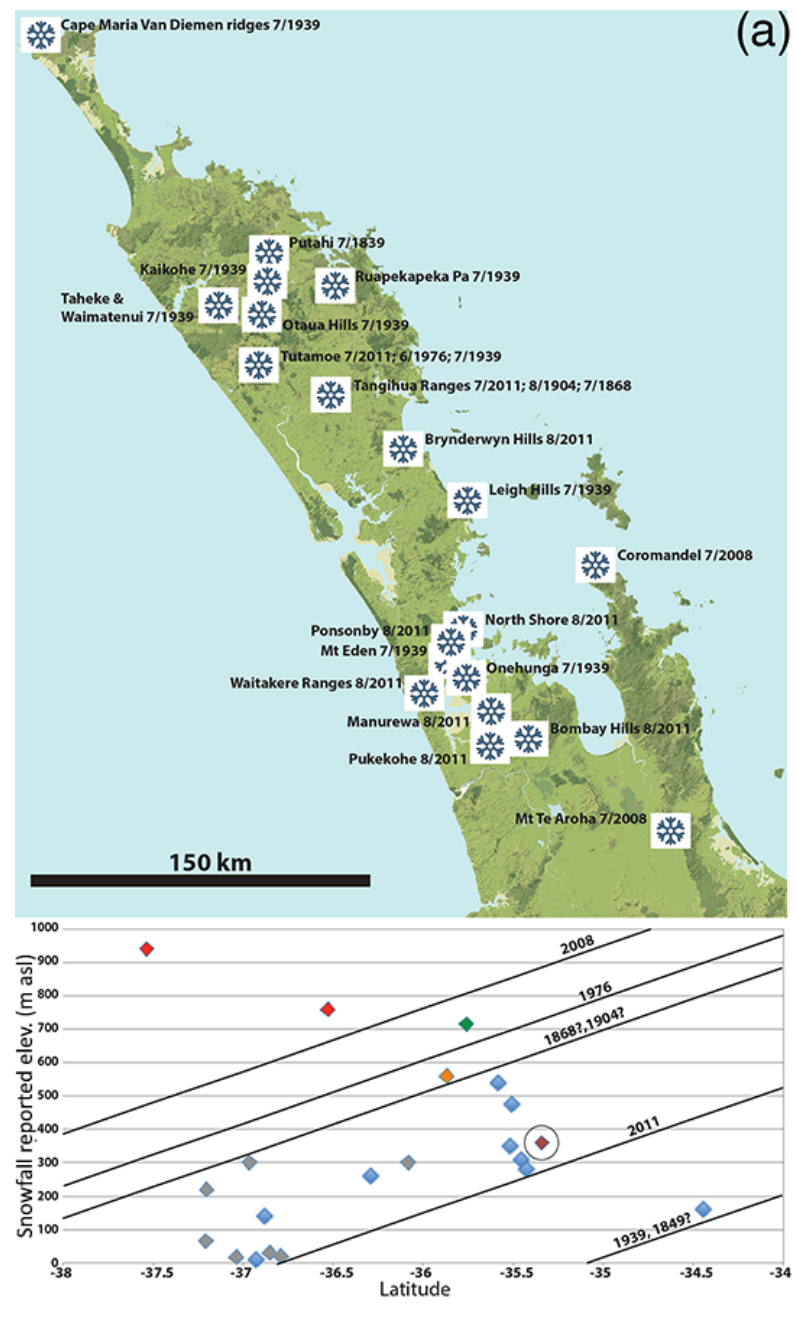
temperatures for all sites, as indicated by the PICT-based reconstructed climate fields, would have been driven by an increase in “trough” types (Kidson, 2000), a reduction in “highs” over the country (the “H” zonal type of Kidson, 2000) and a reduction of “blocking” synoptic types that typ- ically are known for increasing the frequency of northerly quarter flow (Kidson, 2000). There are clear “differences in opinion” amongst the proxy data with regard to what the spe- Clim. Past, 12, 553–573, 2016